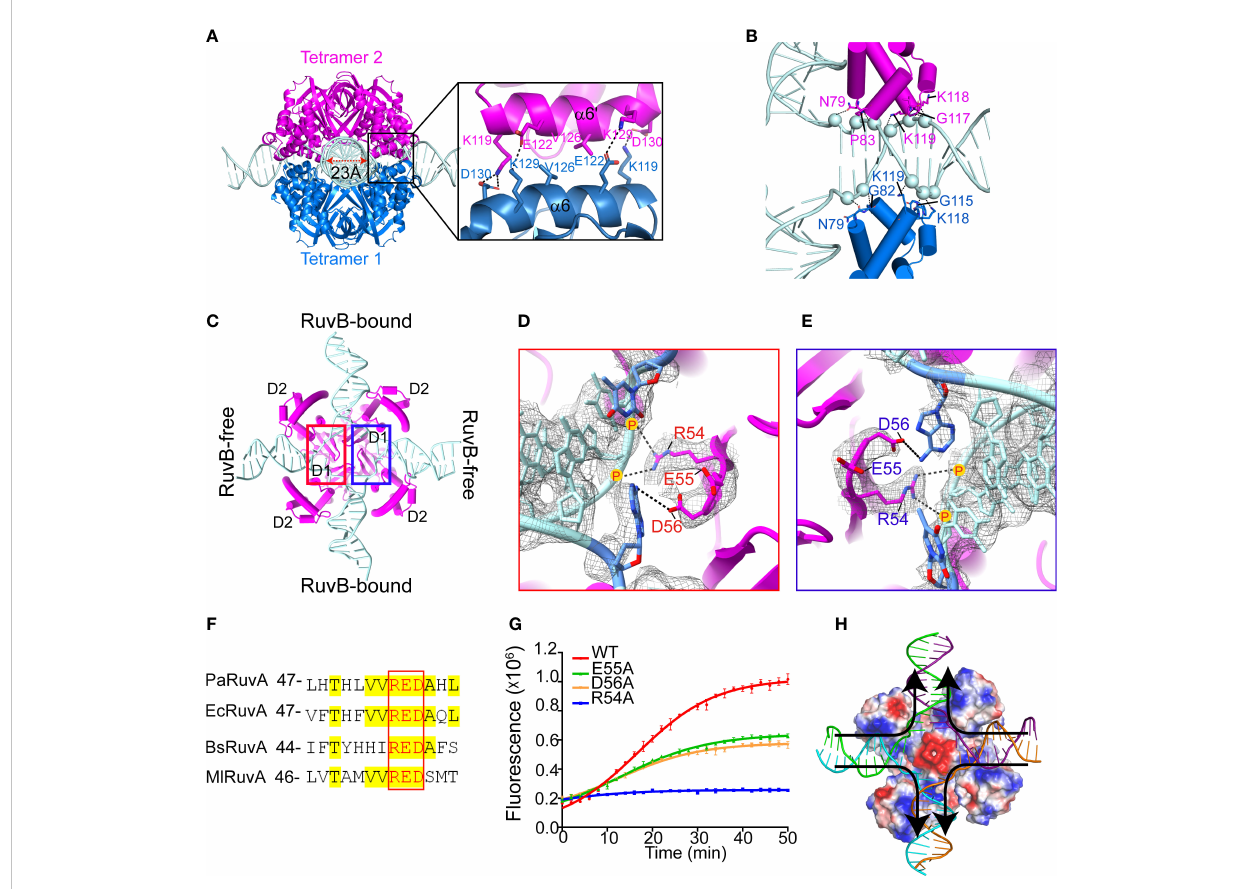
FIGURE 3 Cryo-EM structure of the PaRuvA-HJ complex. (A) Dimerization interface between the two RuvA tetramers, with de fi ned region magni fi ed and shown on the right. RuvA is shown as cartoon representation and HJ is shown as ladder. Key interacting residues are shown in sticks. (B) Zoomed in view of the interaction between HJ duplex arm and RuvA D2 from two separate tetramers, with corresponding residues shown in sticks and DNA backbone phosphates shown in spheres. (C) An interior view of RuvA-HJ complex. (D, E) A close view of the de fi ned regions in (C) . RuvA RED motifs within the tetramer are shown in sticks. DNA is shown in ladder representation. 2mFo-DFc map is contoured at 0.38 s . (F) Sequence alignment of the RED motifs of RuvA from various species. Pa, Pseudomonas aeruginosa; Ec, Escherichia coli; Bs, Bacillus subtilis; Ml, Mycobacterium leprae. (G) Effects of RED motif mutations on the branch migration activity of RuvAB complex by FRET-based assay (mean ± s.d., n = 3 independent experiments). (H) Cartoon diagram of HJ branch migration. RuvA tetramer is shown as surface and colored with its electrostatic potential (red, negative; blue, positive; white, neutral). DNA is shown as ladder. Arrows indicated the direction of branch